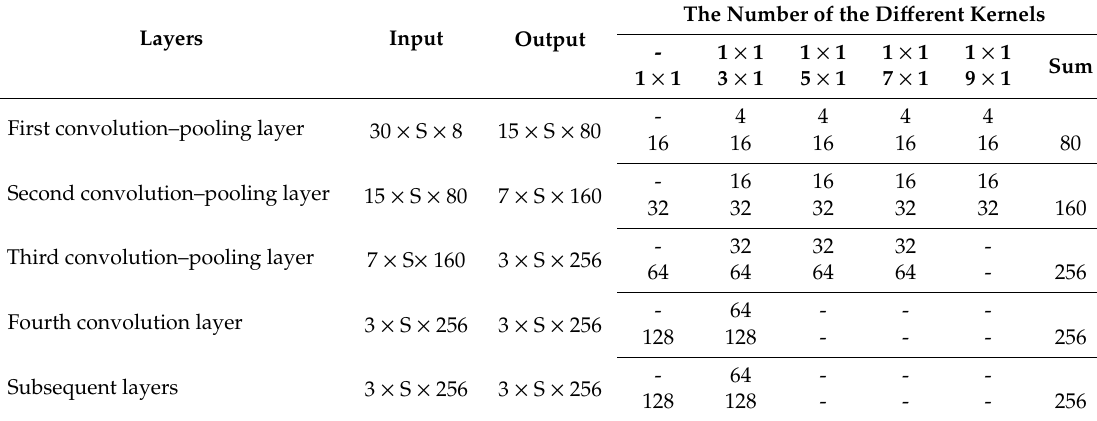
Table 1. The number of di ff erent kernels in each layer (time window